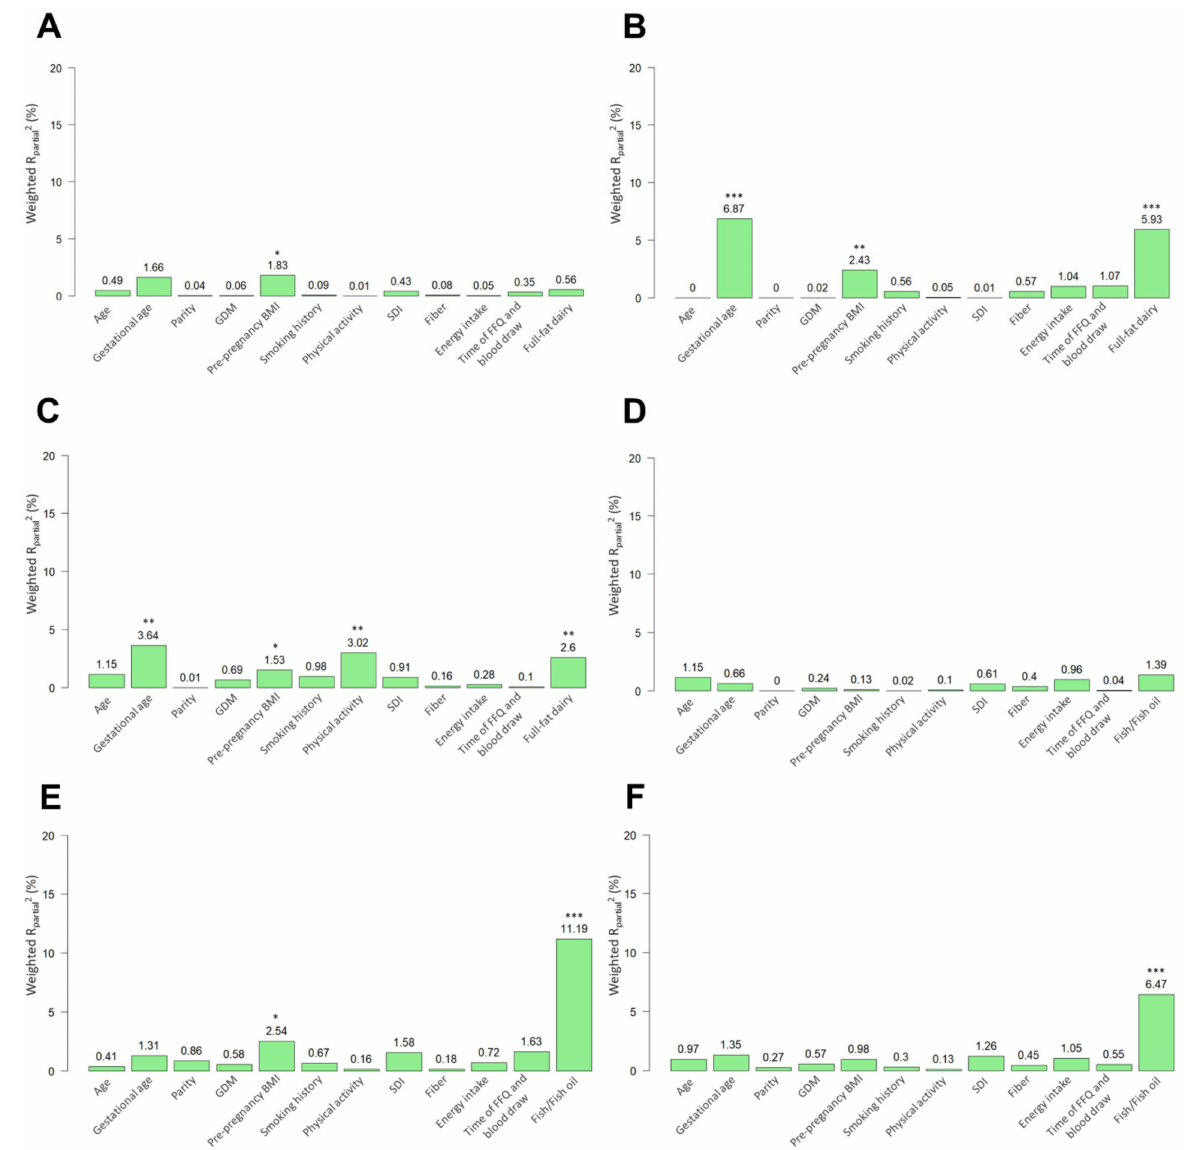
Figure 2. Weighted R partial2 for each factor showing the percentage of explained variability in: ( A ) Myristic acid (14:0), ( B ) Pentadecanoic acid (15:0), ( C ) Heptadecanoic acid (17:0), ( D ) Eicosapen- taenoic acid (EPA, 20:5n-3), ( E ) Docosahexaenoic acid (DHA; 22:6n-3), and ( F ) EPA + DHA in FAMILY cohort. Statistical significance was based on ordinary least squares regression. * p ≤ 0.05, ** p ≤ 0.01, *** p ≤